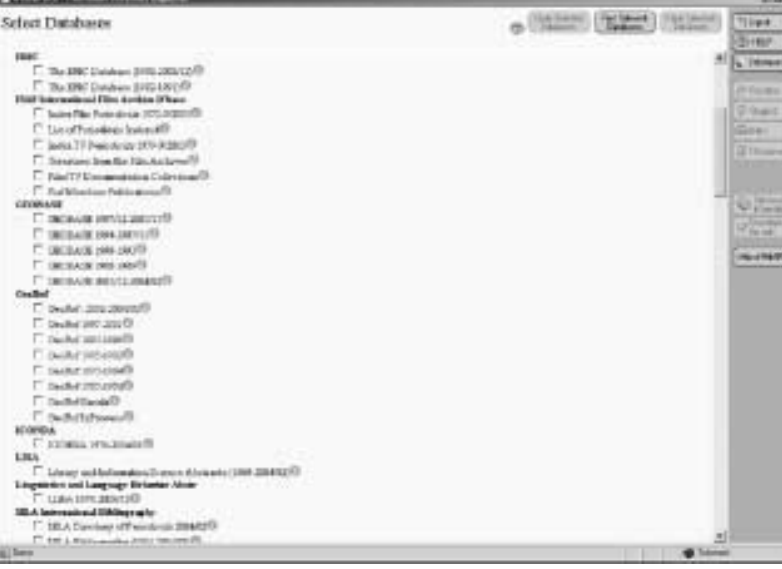
Figure 1. A screenshot from library pages showing database